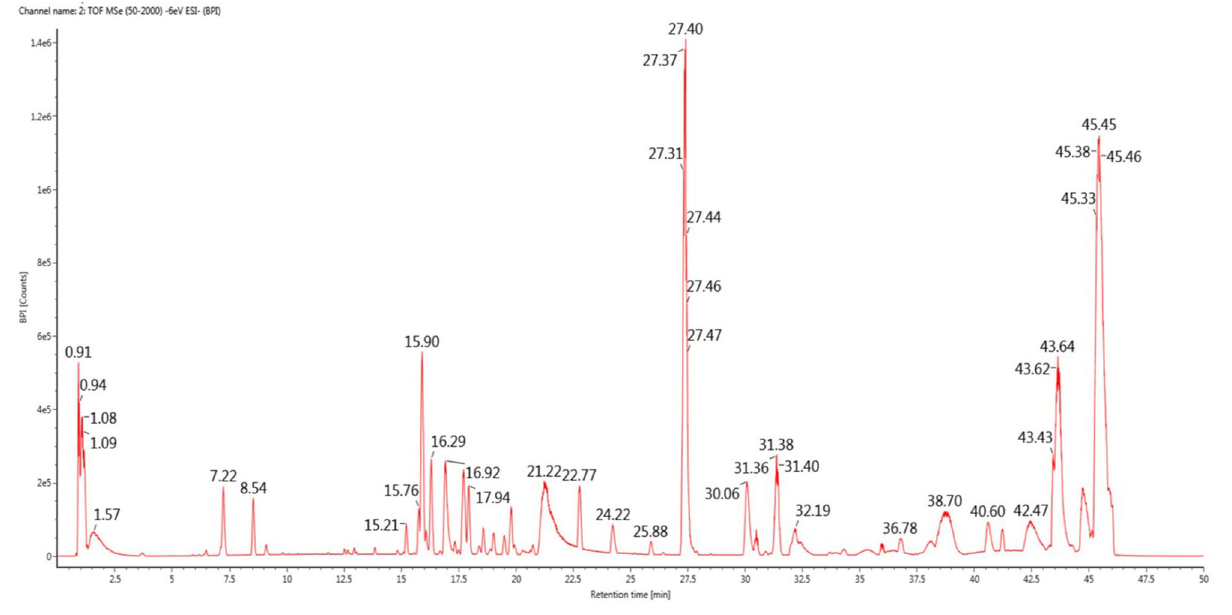
Figure 1. The total ion chromatogram of the extracted of Pholiota adiposa detected by LS-MS.